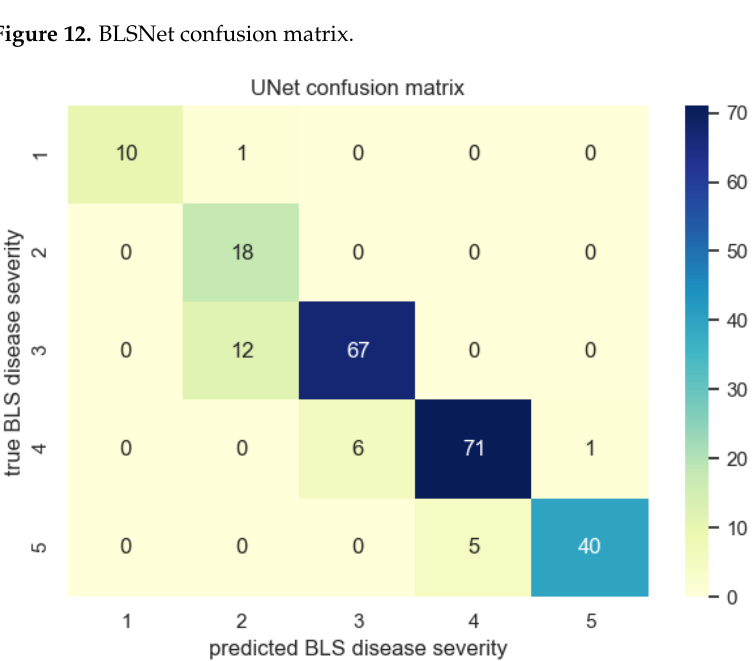
Figure 13. UNet confusion matrix.